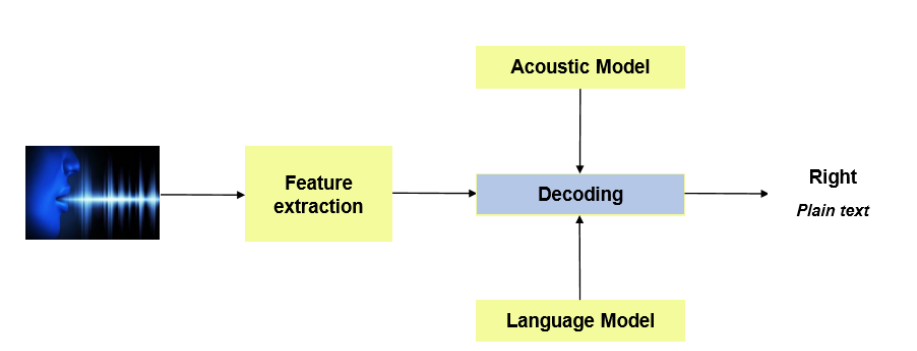
Figure 1. Generic model of an automatic speech recognition (ASR)